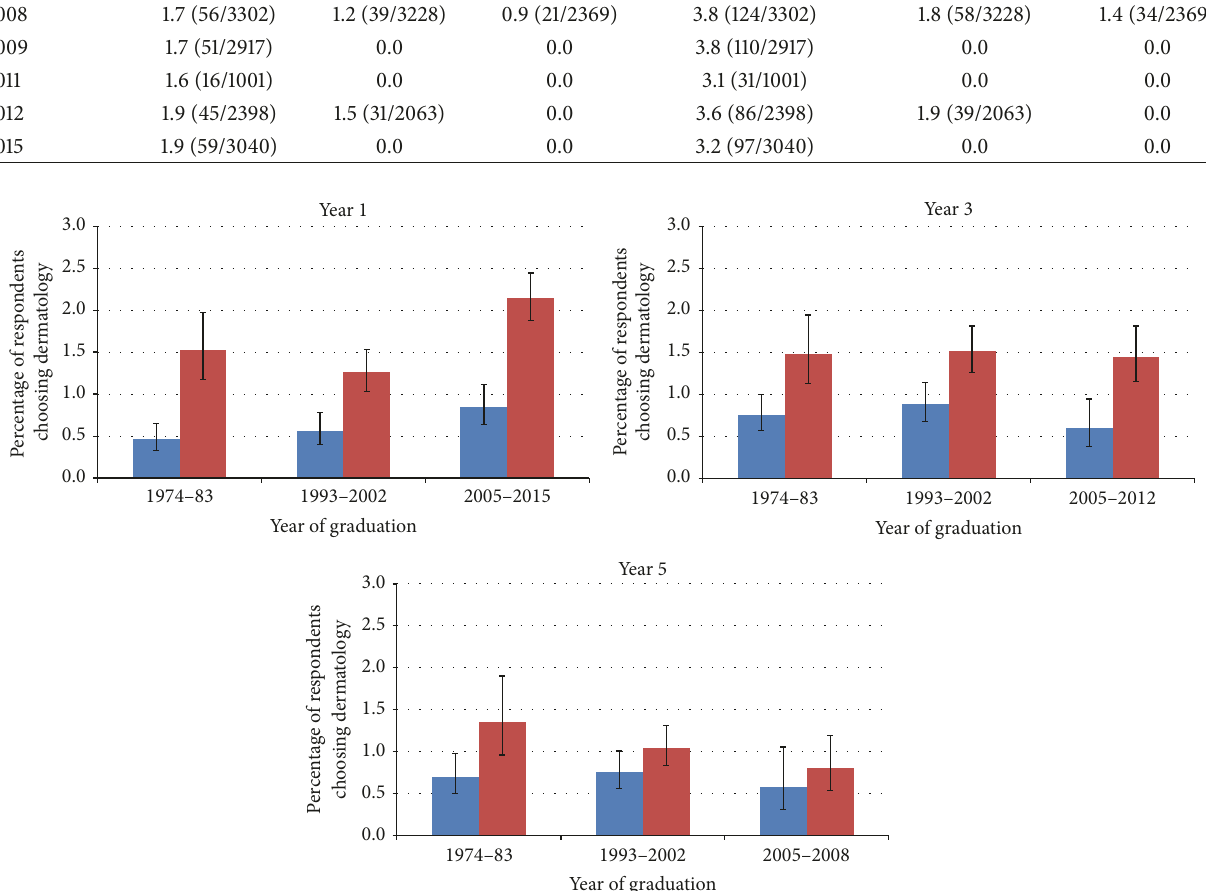
Figure 1: Percentages of men (blue) and women (red) doctors who chose dermatology as a first choice of eventual career one, three, and five years after